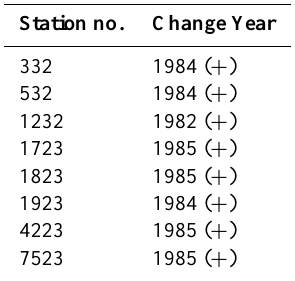
Table 2. Year of significant step change in variance of annual ex- treme daily rainfall (“ + ” denotes a positive shift). Station